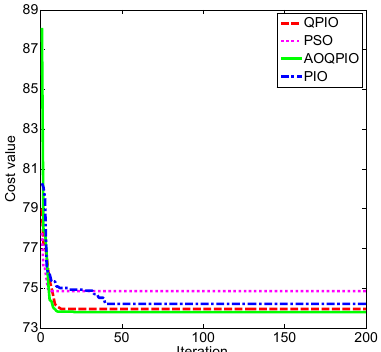
Figure 6. The comparative curves of iteration of the algorithms of the experiment carried out in map 1.